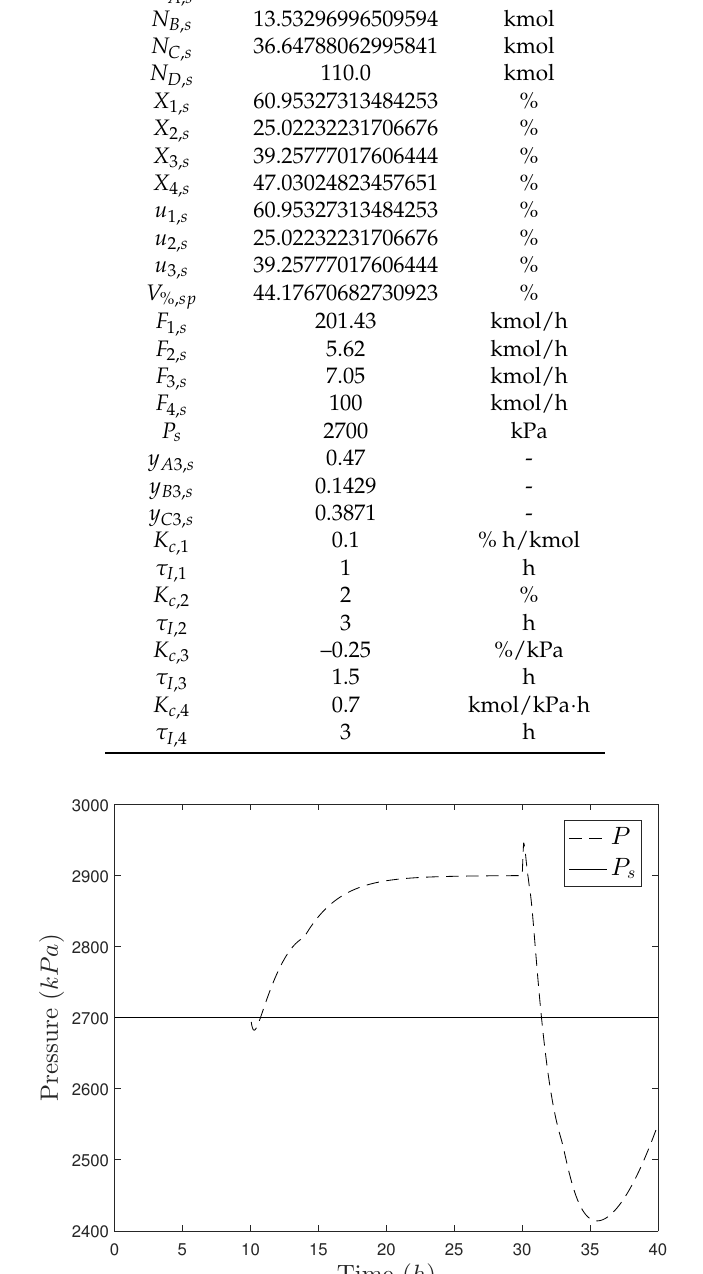
Figure 1. Pressure trajectory for the system of Equations (23)–(45) for a falsified y A 3 measurement set at 1 between 10 and 30 h of operation under proportional-integral (PI)